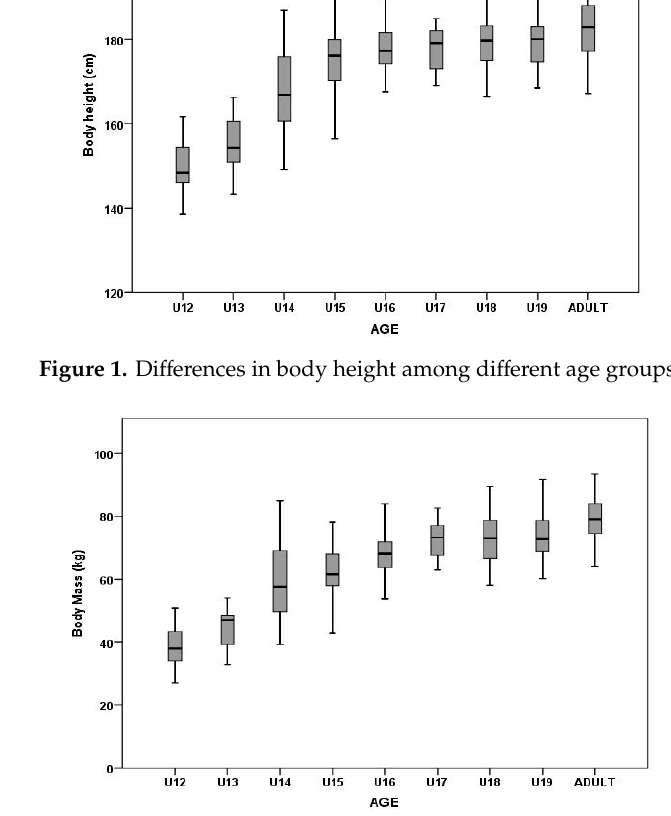
Figure 2. Di ff erences in body mass among di ff erent age Figure 2. Differences in body mass among different age groups. Figure 2. Differences in body mass among different age groups.